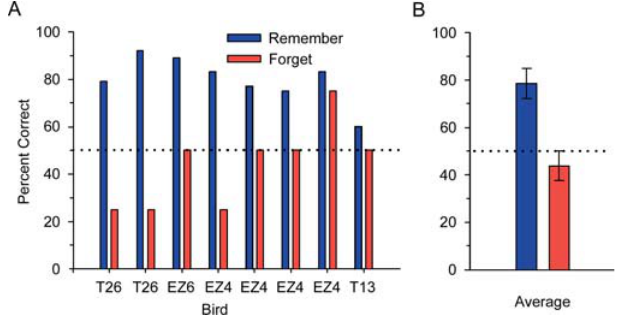
Figure 5. Performance on Probe Trial Sessions (A) The performance on each of the eight sessions with forget-probe trials. (B) The performance on the probe sessions ( 6 1 SE) averaged across all four birds. The dotted line represents chance levels of perform- ance. DOI: 10.1371/journal.pbio.0030190.g005